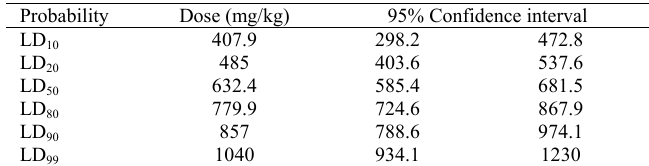
Fig. 1: Fipronil 96-h predicted mortality – dose response curve for Caspian kutum fingerlings based on parameter estimates from the probit analysis Table 4: Dose-response values after i.p. injection into Caspian kutum (degree of freedom was 1, P<0.05).